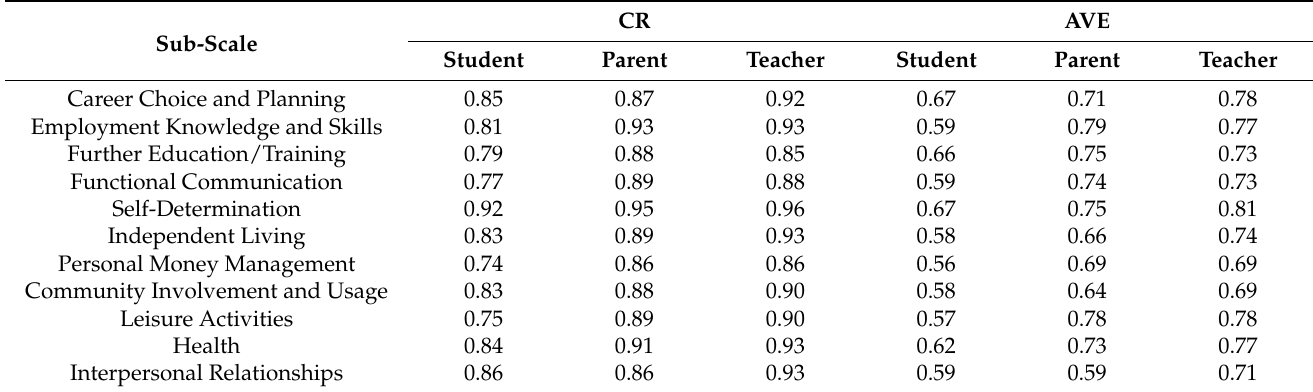
Table 4. Composite reliability and average variance extracted for Model